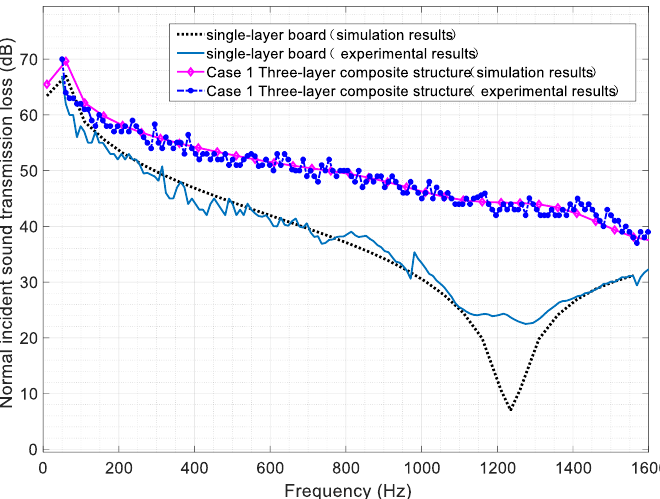
Figure 4. Comparison of simulation and experimental results.